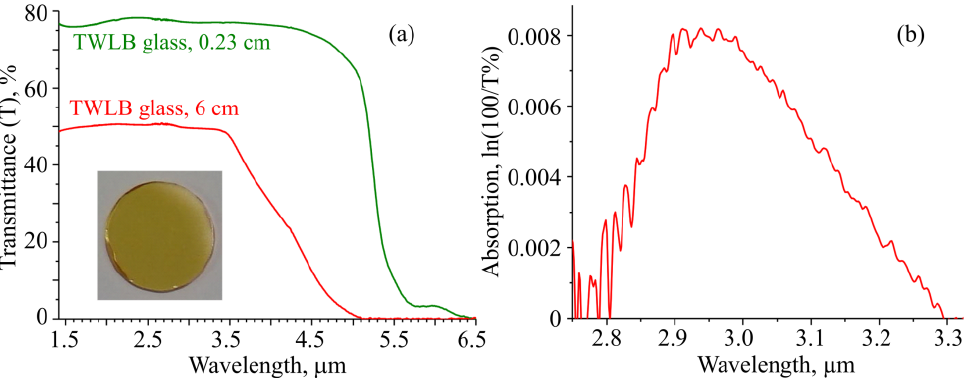
Figure 1. ( a ) Transmittance spectra of produced tellurite-glass samples with photo of 0.23 cm sample in the inset. ( b ) Absorption spectrum within OH band of 6 cm sample.